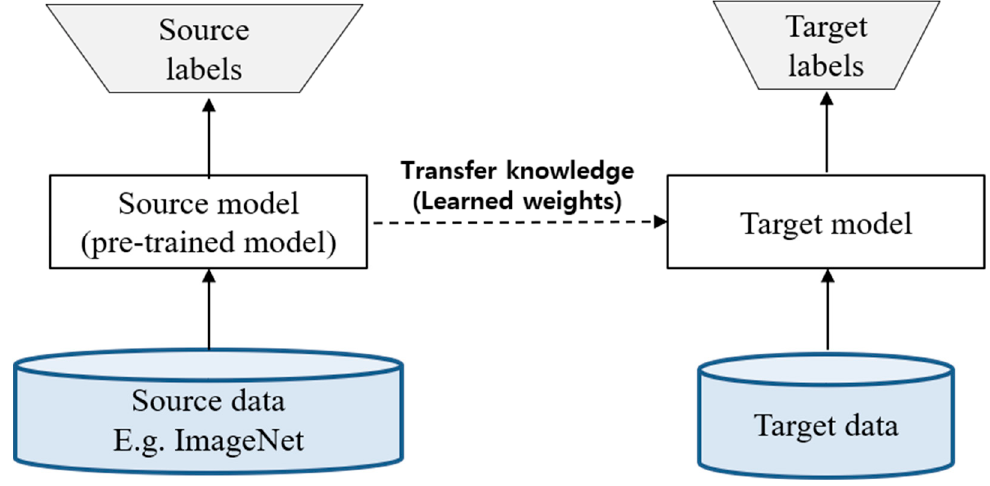
Figure 1. Transfer learning.